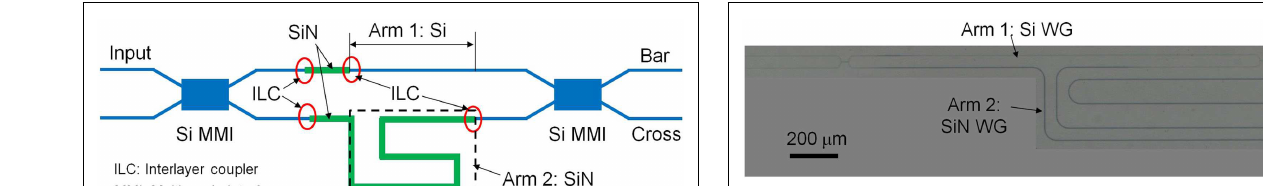
FIGURE 1 | Schematic of Si–SiN-waveguide DL MZI .